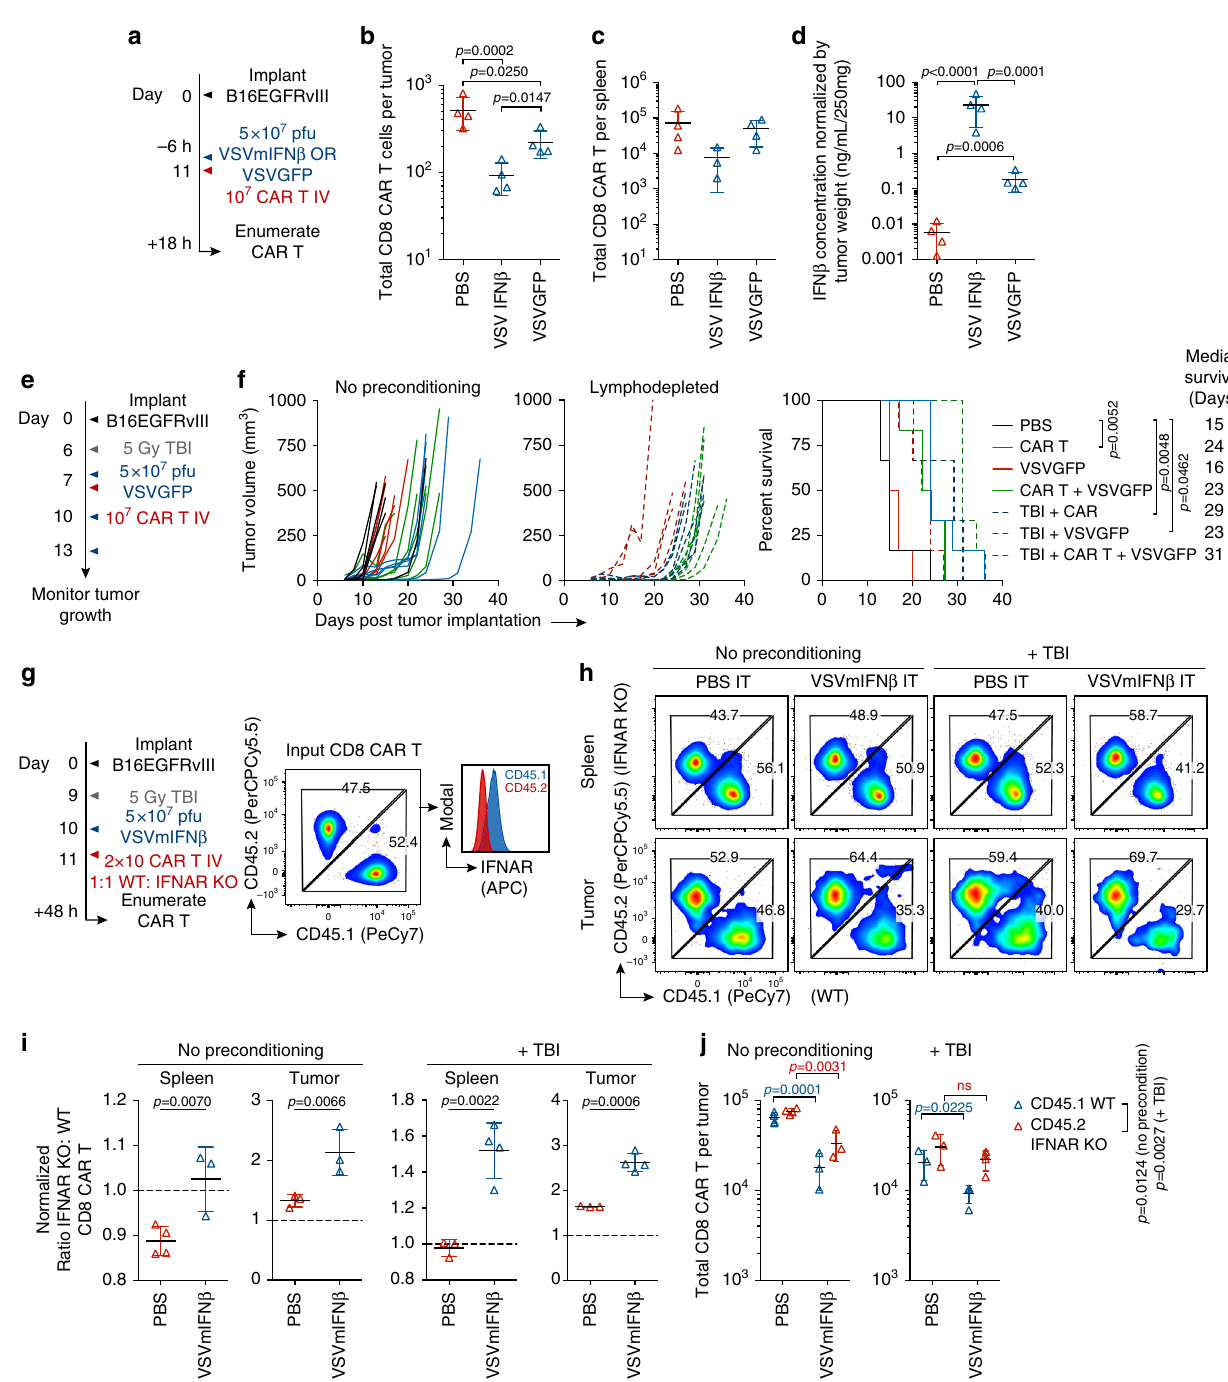
Fig. 3 Oncolytic virus-associated type I IFN is deleterious to adoptively transferred CAR T cells. a Mice bearing B16EGFRvIII tumors received a single intratumoral injection of 5 × 10 7 pfu of VSVmIFN β or VSVGFP or PBS 6 h prior to adoptive transfer of 1 ×10 7 EGFRvIII CAR T cells on day 11. The next day, the number of viable CD8 CAR T cells was quanti fi ed in the tumor ( b ) and spleen ( c ) and represented as mean ±SD for n = 4/group. d IFN β was quanti fi ed in the tumor homogenate, normalized by tumor weight, and represented as mean ±SD for n = 4/group. e Mice bearing B16EGFRvIII tumors were treated with 5 × 10 7 pfu VSVGFP or PBS 6 h prior to administration of 1 × 10 7 EGFRvIII CAR T cells on day 7. Select groups received a lymphodepleting dose of radiation (5 Gy TBI) on day 6, and 2 additional doses of 5 × 10 7 pfu VSVmIFN β on days 10 and 13. n = 6/group. f Tumor growth is shown in the left panel and overall survival is shown in right panel. g Mice bearing B16EGFRvIII tumors received a single intratumoral injection of 5 × 10 7 pfu of VSVmIFN β or PBS 48 h prior to adoptive transfer of 1 × 10 7 WT CD45.1 EGFRvIII CAR T cells + 1 × 10 7 transgenic IFNAR1 KO CD45.2 EGFRvIII CAR T cells. h The ratio of IFNAR KO to WT CD8 CAR T cells in the tumor and in the spleen is shown for a single representative mouse per group. i The IFNAR KO: WT ratio normalized to the input ratio and represented as mean ± SD for n = 3 or 4/group. j The total number of CD8 CAR T cells of each type was enumerated in the tumor and spleen and represented as mean ± SD for n = 3 or 4/group. Experiments were performed once. P -values were determined using a one-way ANOVA with a Tukey multiple comparisons post-test using log-transformed data ( b , d ), a Log-rank Mantel – Cox test ( f ), unpaired two tailed T tests ( i ) or a two-way ANOVA with a Sidak multiple comparisons post-test ( j ). Statistical signi fi cance set at p < 0.05, ns > 0.05. Source data are provided in the Source Data